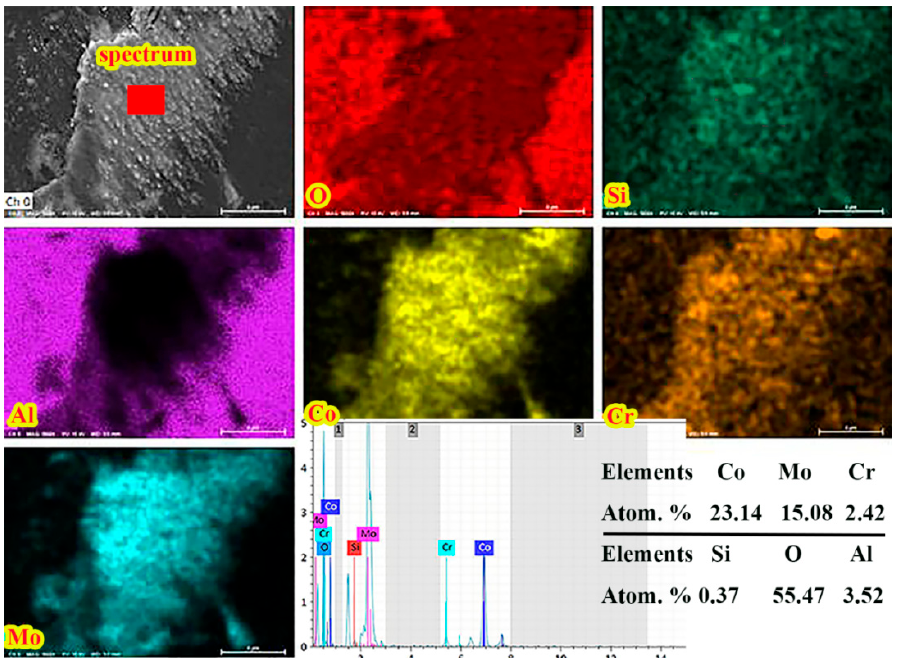
Figure 17. Elemental maps acquired from the worn surface of the Al 2 O 3 pair for the coating annealed for 3 h after the sliding distance of 500 m.